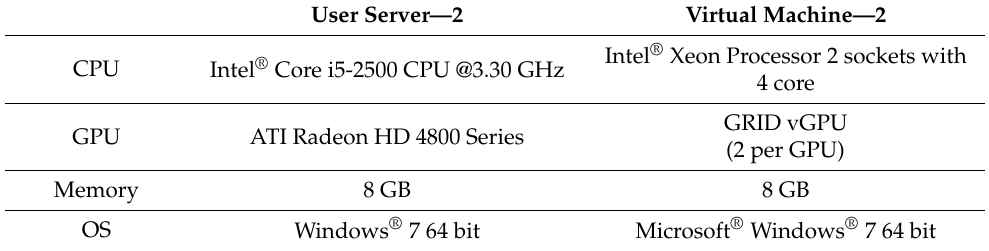
Table 12. Condition 2 of test simulation.